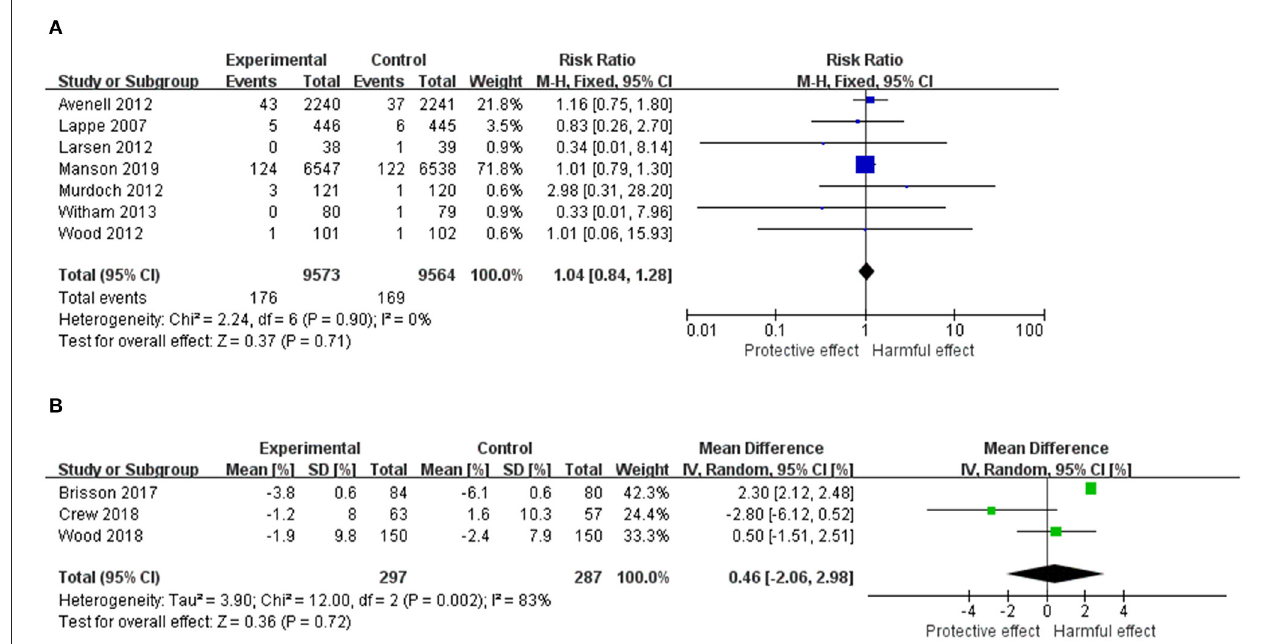
FIGURE 2 | (A) Forest plot of the RR of breast cancer for Vitamin D supplementation vs. placebo. (B) Forest plot of the mean difference of MD change for Vitamin D supplementation vs. placebo. The size of the data markers (squares) for the RR/mean difference corresponds to the weight of the study in the meta-analysis; the horizontal lines correspond to the 95% CI values. RR, risk ratio; MD, mammography density.